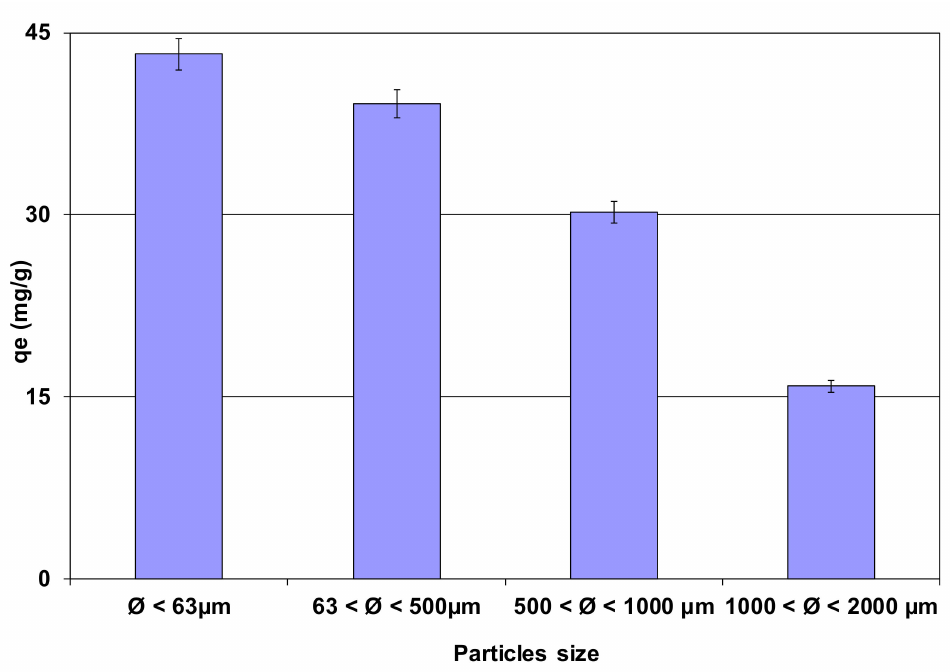
Figure 1. Impact of lignite particle size on Cd and Cu removal efficiency (C 0 = 100 mg L − 1 , D = 2 g L − 1 ; t = 60 min; pH = 5; T = 20 ± 2 ◦